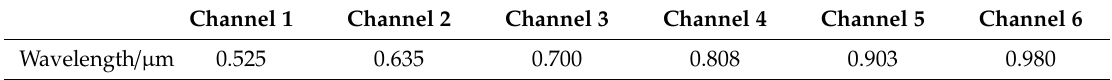
Figure 6. A schematic diagram of the optical fiber transmission structure. Table 1. The effective wavelength of each channel.